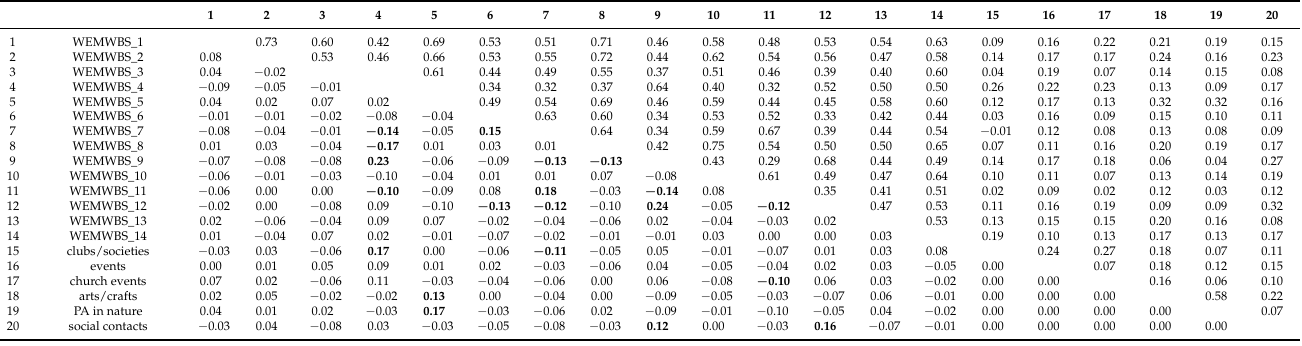
Table A1. Observed polychoric correlation matrix (upper diagonal) and correlation residuals (lower diagonal) in the main model.